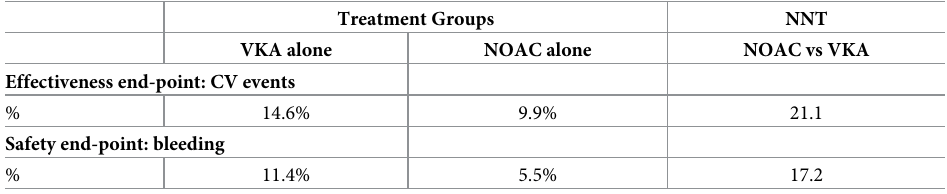
Table 3. Number Needed to Treat NOAC vs VKA (VKA: VKA Group—NOAC: NOAC